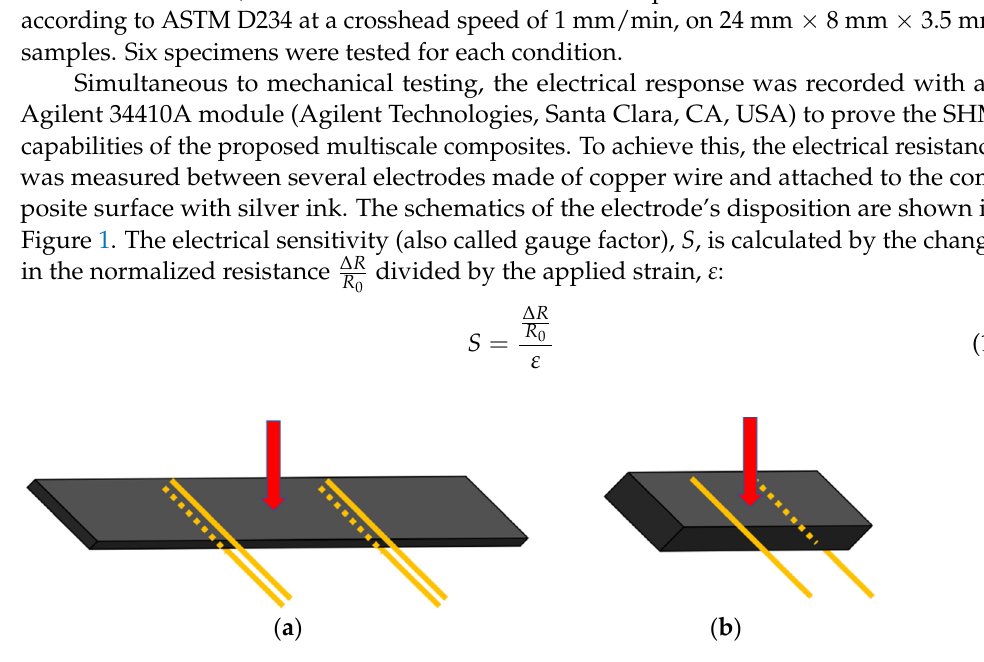
Figure 1. Schematics of electrode disposition in flexural ( a ) and ILSS ( b ) tests, where the red arrow denotes the direction of the applied load.